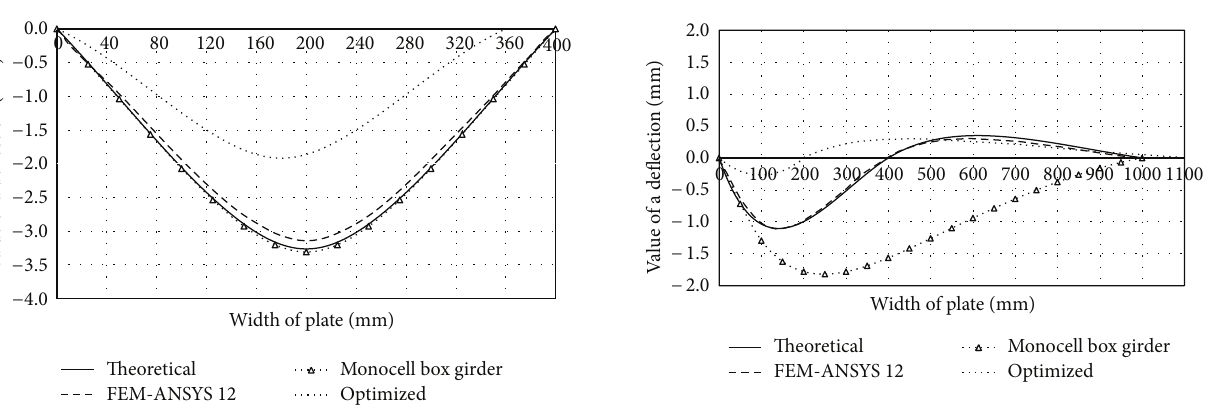
Figure 4: Comparative diagram of deflection of the girder’s upper flange plate.